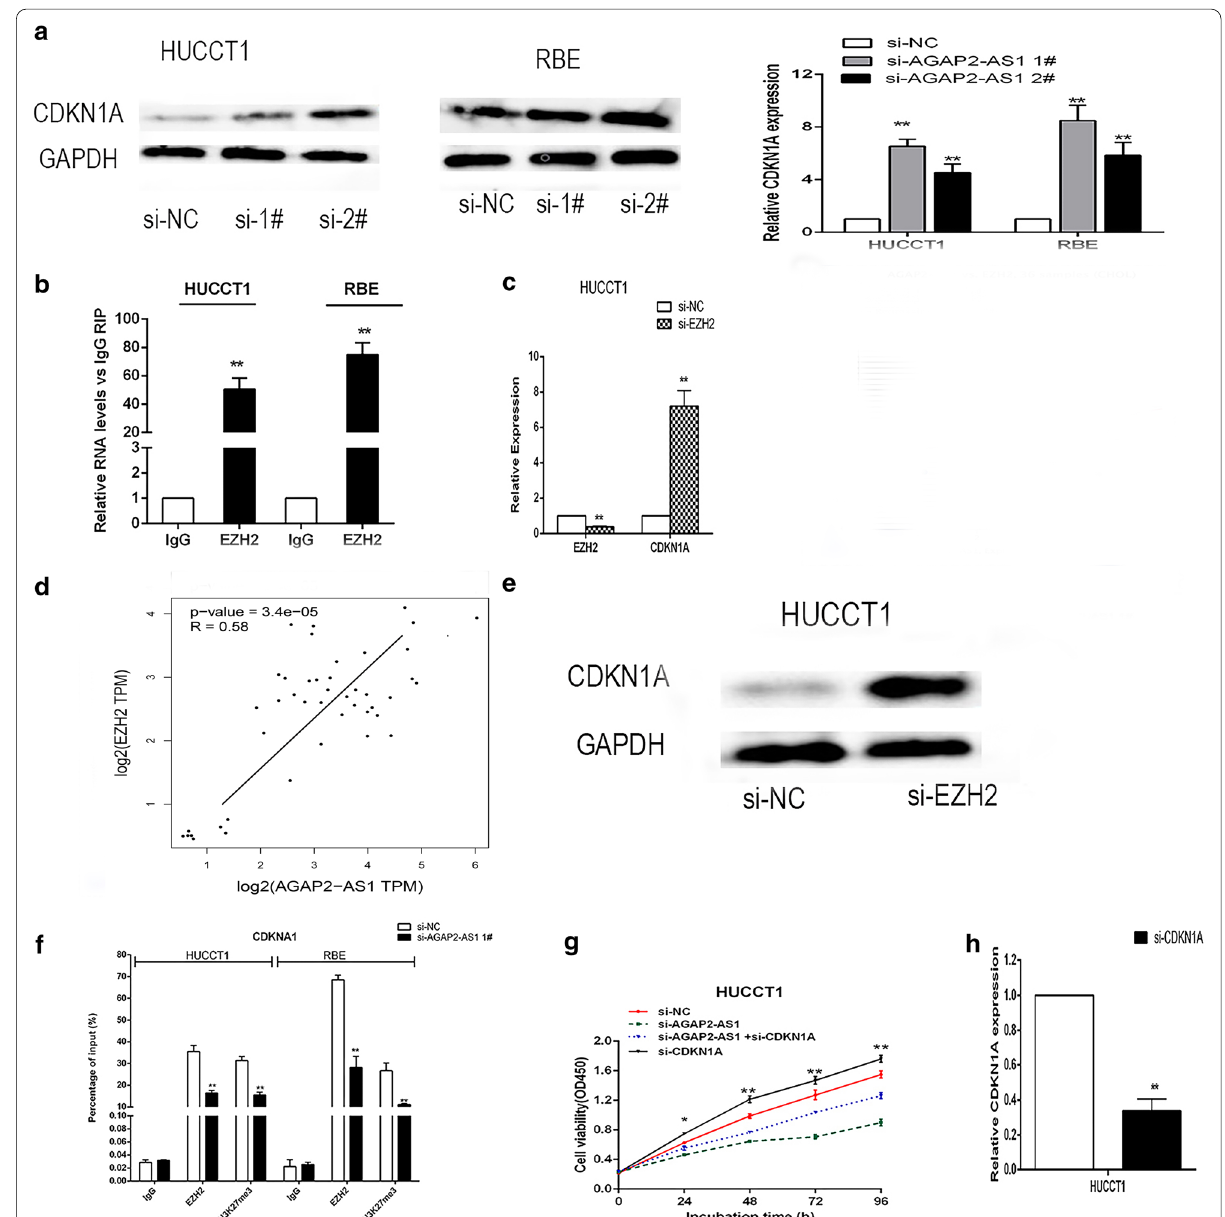
Fig. 4 AGAP2-AS1 epigenetically silences CDKN1A transcription by binding to EZH2. a CDKN1A expression was determined by qRT-PCR and Western blot assays after AGAP2-AS1 knockdown by transfection. b RIP assays were performed in HUCCT1and RBE cells and the coprecipitated RNA was subjected to qRT-PCR for AGAP2-AS1. c , d Bioinformatics predicts that there is a positive correlation between AGAP2-AS1 and EZH2 and a negative correlation between EZH2 and CDKN1A. e Western Blot assays were performed to determine the expression of EZH2 in HUCCT1 cells after EZH2 knockdown. f ChIP-qRT-PCR for EZH2 occupancy and H3K27me3 binding to the CDKN1A promoter in HUCCT1 and RBE cells. g , h CCK-8 assays were used to determine the viability of si-AGAP2-AS1 and si-CDKN1A co-transfected HUCCT1 cells. Representative images and data based on three independent experiments. Bars: sd, *P < 0.05, **P < ±